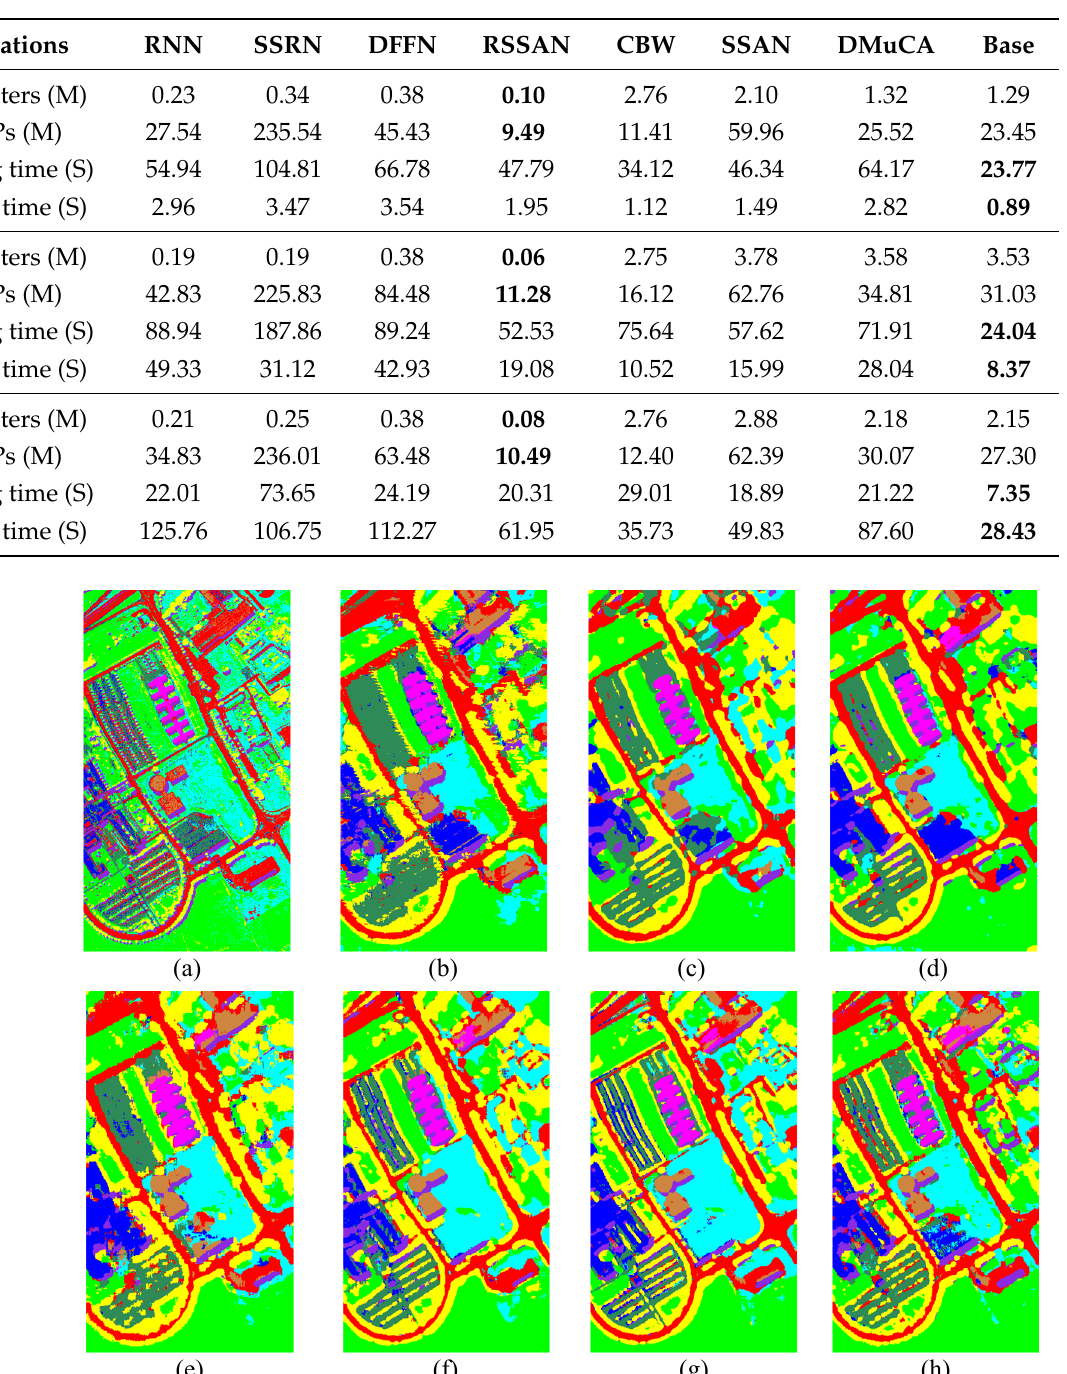
Table 13. The number of training parameters, computational FLOPs, and the running time of the corresponding experiments from the deep frameworks. The best results are highlighted in bold font.